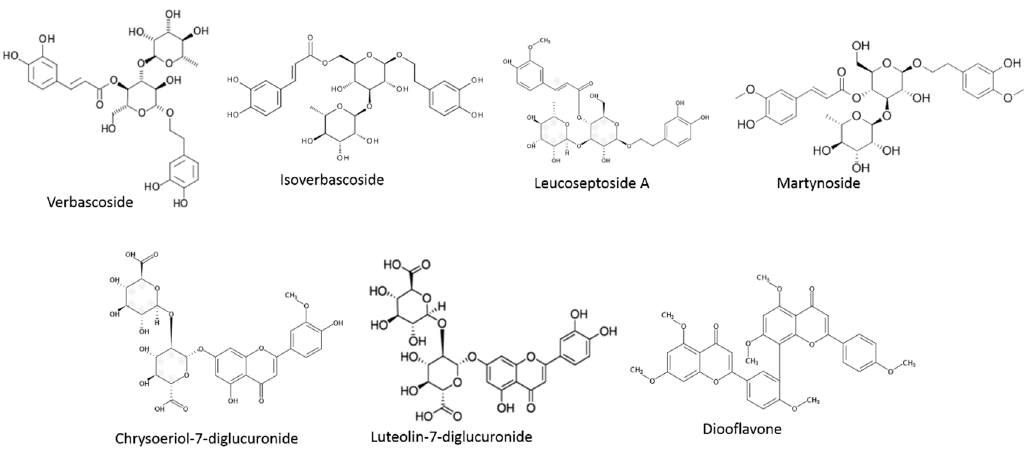
Figure 2. Representative phenolics in Lippia species.